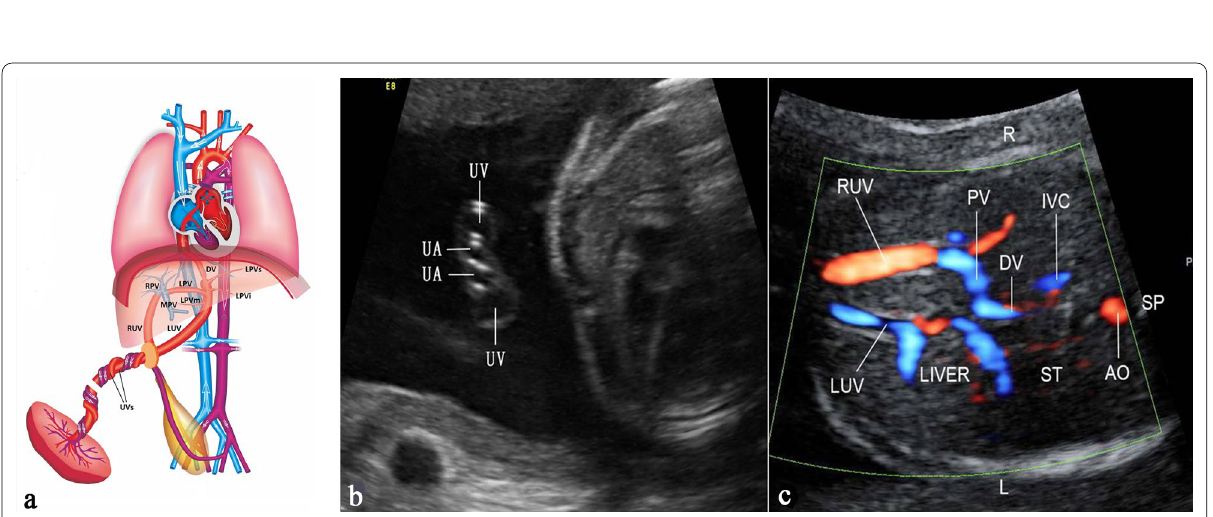
Fig. 9 The scheme ( a ) and ultrasound images ( b , c ) of DUV (intrahepatic